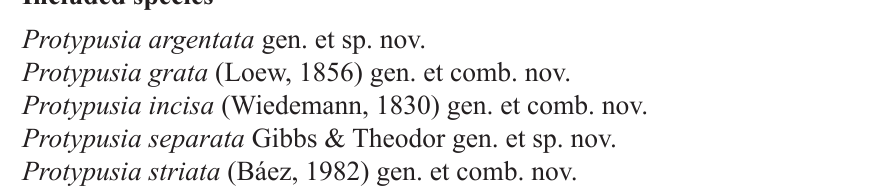
From Latin ‘ argentum ’ meaning ‘silver’, refers to the silver-grey dusting and white hairs covering much of the bodies of both sexes.